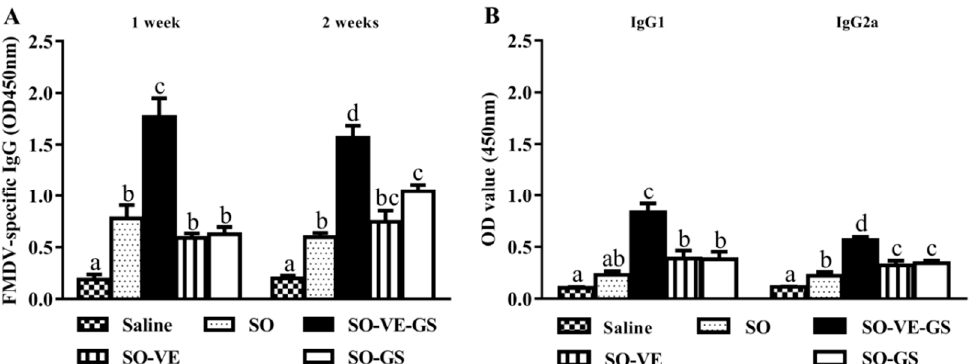
Figure 1. Serum FMDV(foot and mouth disease virus)-specific antibody response. Mice ( n = 6/group) were i.m. immunized twice at a 2-week interval with the FMDV antigen in saline solution or emulsified in SO alone or SO with VE-GS (VE 10 μ g + GS 6 μ g) or VE (10 μ g) or GS (6 μ g). ( A ) Blood samples were collected 1 and 2 weeks after the boost to measure an FMDV-specific IgG. ( B ) IgG1 and IgG2a were measured 2 weeks after the boost. The values are presented as means ± SE. Bars with different letters are statistically different ( P < 0.05).